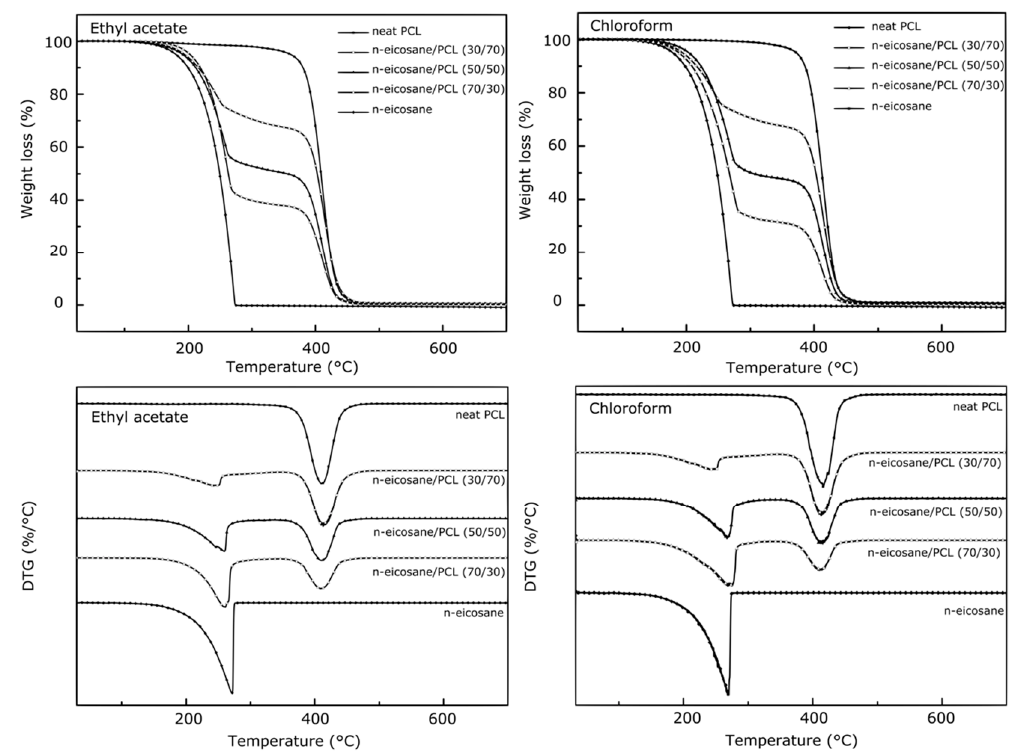
Figure 6. TG and DTG curves of n -eicosane, neat PCL and the microencapsulated n -eicosane. On the one hand, even if the initial degradation temperatures are close to the n -hexadecane, the maximum degradation temperatures in the first stage are significantly lower than the raw compound, increase with the increase in the loading content, and are not very dependent on the solvent used. On the other hand, when n -eicosane was used as a core compound, the initial thermal ◦ degradation temperatures are 10 to 18 C higher than that of the raw compound one and decrease with the increase in the loading content. The maximum degradation temperatures in the first stage are ◦ 30 C lower than n -eicosane one for low loading content and increase up to the n -alkane one at higher loading content. Furthermore, chloroform based microparticles have better thermal stability than the ethyl acetate-based one. This stability is related to the a ffi nity between PCL and n -alkanes chains in the solvent solutions, which can favorize the entanglement during the electro-spraying